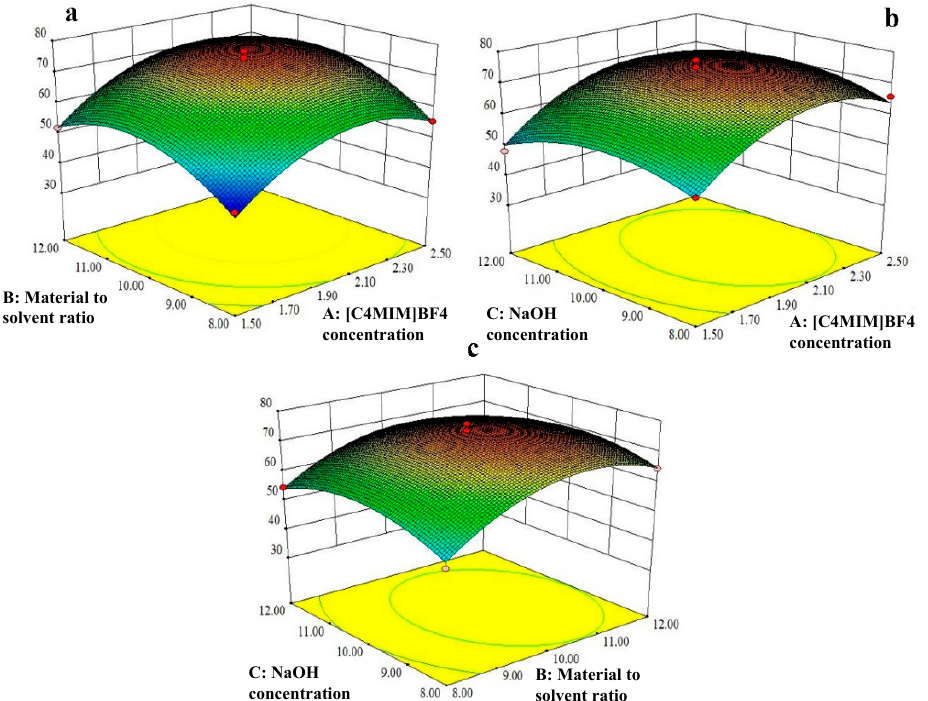
Figure 4. ( a ): Response surface plot of effect of [C 4 MIM]BF 4 concentration (A, mol/L) and material to solvent ratio (B, g/mL) on the purity of saponins by ionic liquid purification; ( b ): response surface plot of effect of [C 4 MIM]BF 4 concentration (A, mol/L) and NaOH concentration (C, %) on the purity of saponins by ionic liquid purification; ( c ): response surface plot of effect of material to solvent ratio (B, g/mL) and NaOH concentration (C, %) on the purity of saponins by ionic liquid purification.